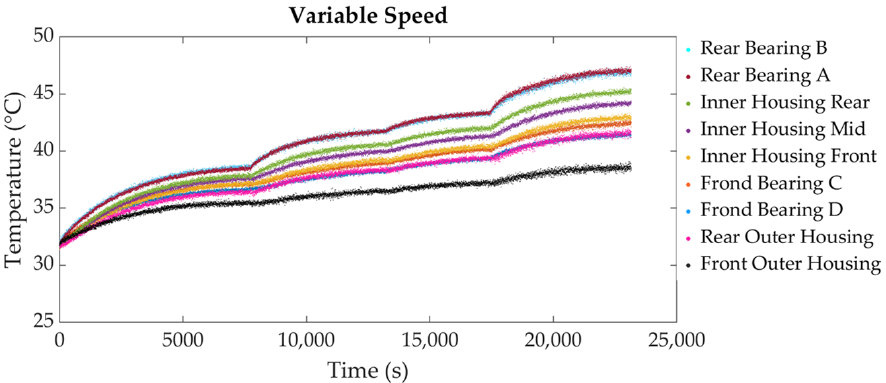
Figure 4. The demonstration of the feature temperatures measurement results under variable speed: 5000 → 6000 → 7000 → 8000 rpm. 5000 → 6000 → 7000 → 8000